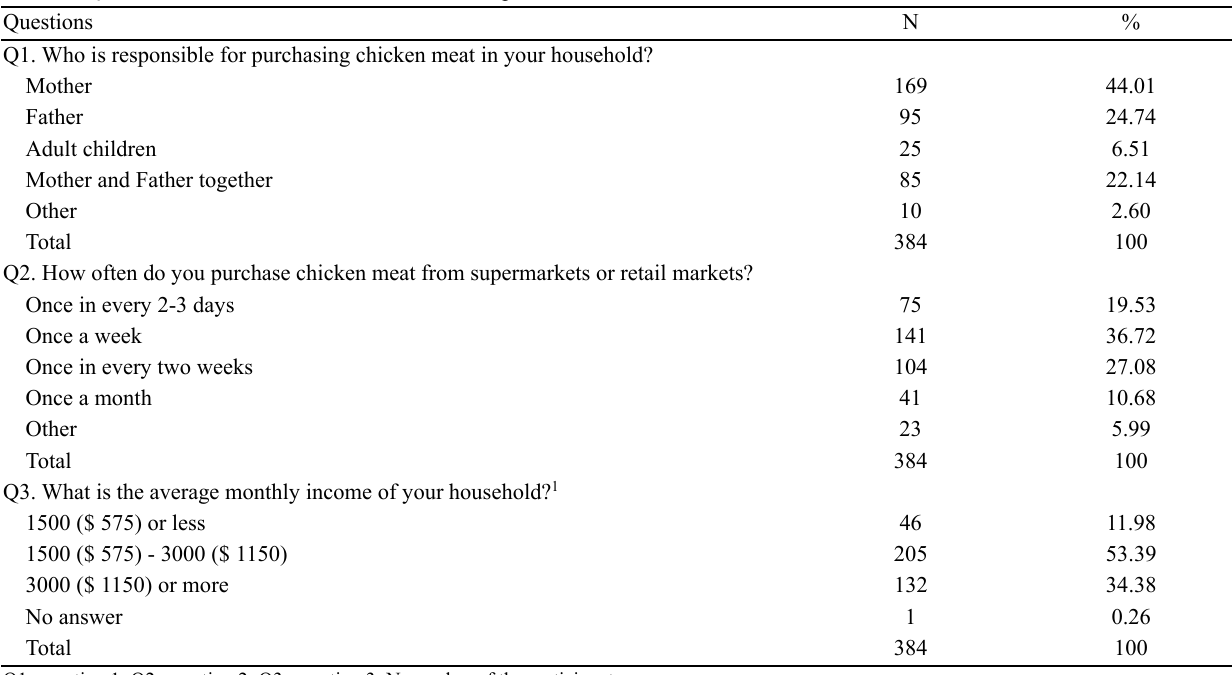
Table 1. Questions related to consumers’ chicken meat purchase habits and income levels